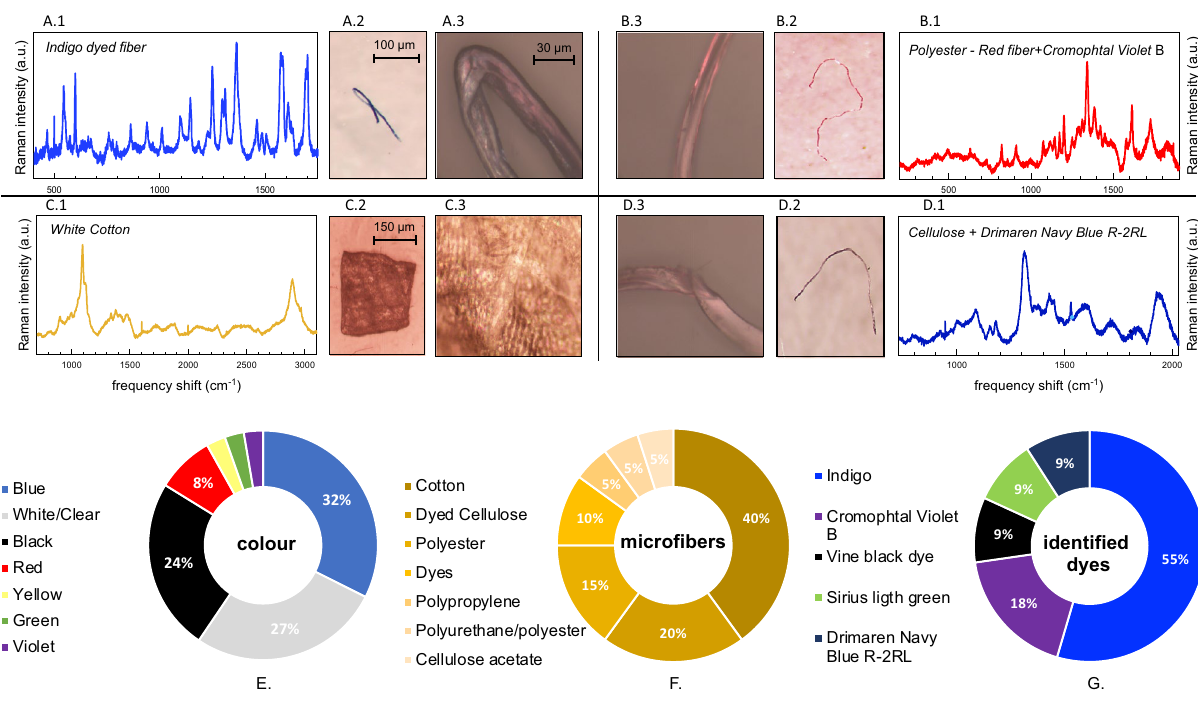
Figure 1. Selected set of anthropogenic microparticles (AMs) isolated from the gastrointestinal tract (GIT) of Trematomus bernacchii samples caught in 1998 in Antarctica (Terra Nova Bay, Ross Sea) and provided by the Antarctic Environmental Specimen Bank. AMs have been identified analyzing the spectra measured by means of micro-Raman spectroscopy (panels A.1 , B.1 , C.1 , D.1 ), after image acquisition with an optical stereomicroscope (4x, Leica M205C; panels A.2 , B.2 , C.2 , D.2 , scale ratio for panel B.2 and D.2 as in panel A.2 ) and a Raman confocal microscopy (50 × , Olympus BX41; panels ( A.3 , B.3 , C.3 , D.3 ), scale ratio for all panels indicated in panel ( A.3 ). The 50 × magnification allows us to appreciate: the rigid-rod fiber of polyester ( B.3 ); the texture of the cotton fabric ( C.3 ); the flat and slightly twisted ribbons of cellulosic fibers ( D.3 ). Bottom panels: Distribution percentage of colour (%) (panel E ), composition (panel F ) and dye type (panel G ), for all the identified AMs ingested by Trematomus bernacchii